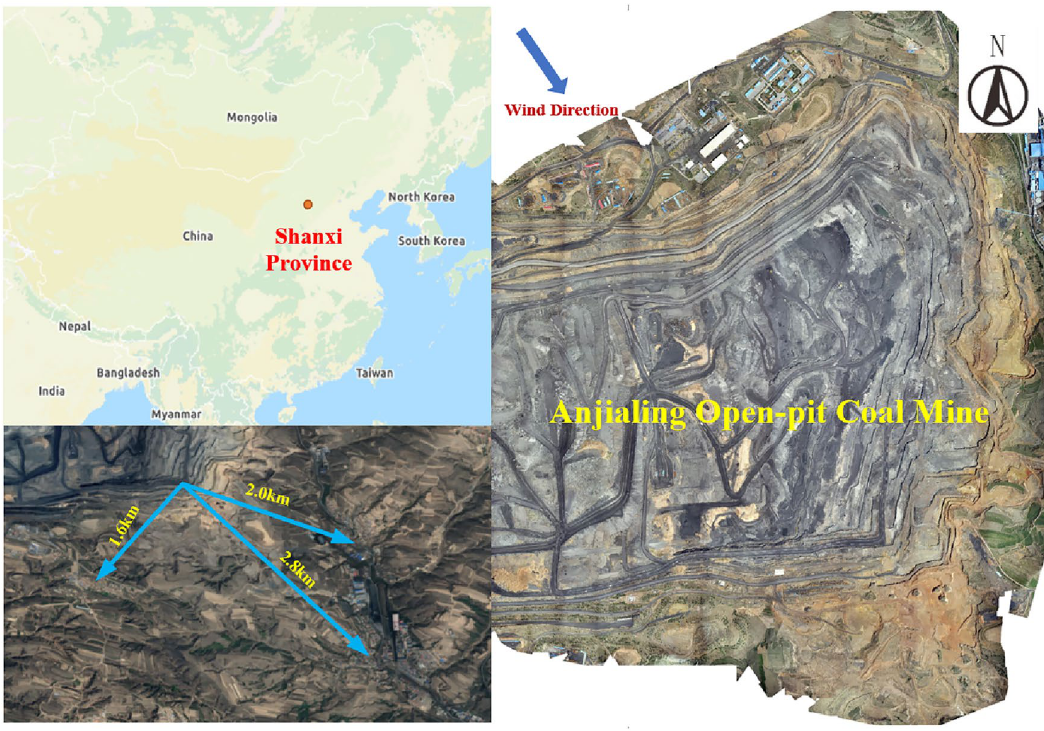
Figure 1. Location map of the study area. Maps were created using WPS for Windows (version 11.1.0.13703. https:// www. wps. cn), the original image freely available in Amap (https:// www. amap. com).